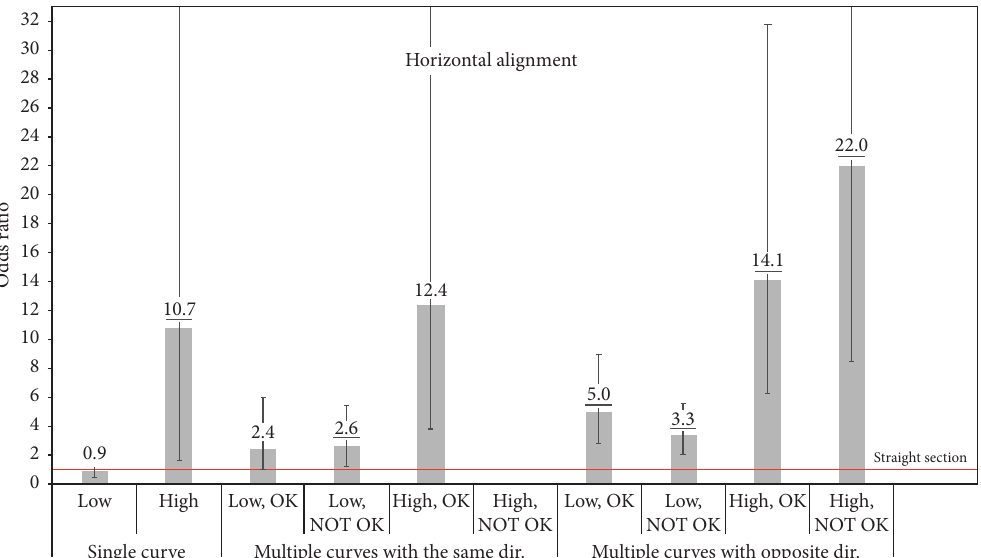
Figure 3: Odds ratio for horizontal alignment and 95% confidence intervals. Significant ( p < 0 . 05) results are underlined.